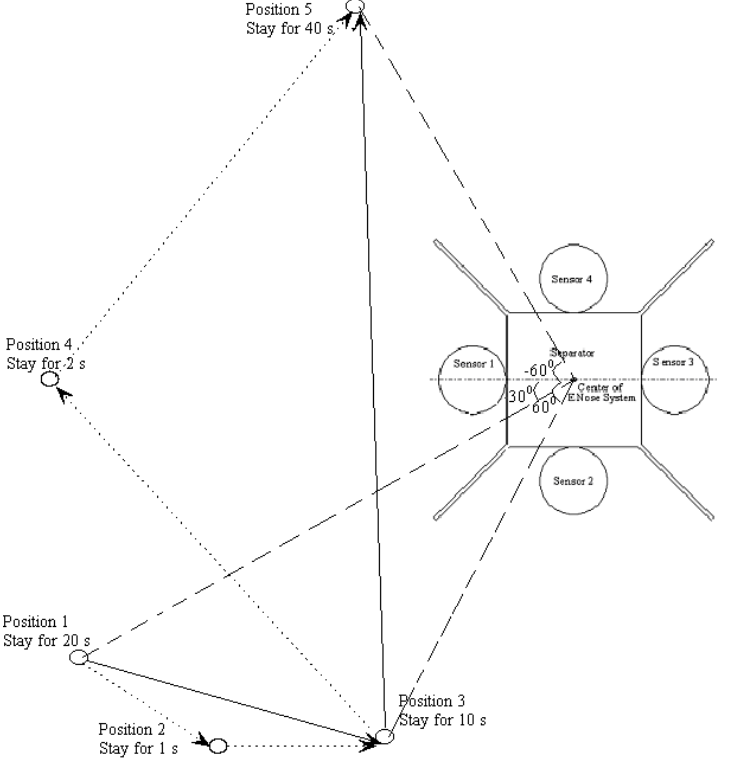
Figure 10 . Preset movement sketch map for dynamic source.